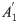
Bifurcations are predicted using data from the pre-bifurcation regime.The method predicts the edges of the bi-stable region using data either from outside or inside of this zone. In this example, the bifurcation at A is predicted from data collected at A
1 and A
2 (or A1' and A2'), while the bifurcation at B is predicted from data at points B1 and B2 (or B1' and B2').